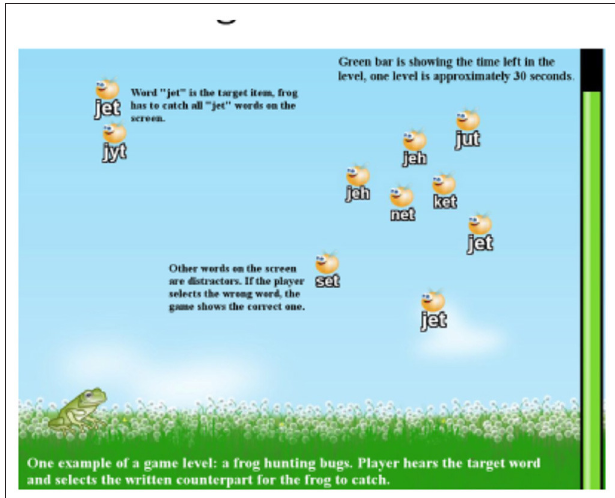
FIGURE 2 | Introducing connections between spoken and written in English in the